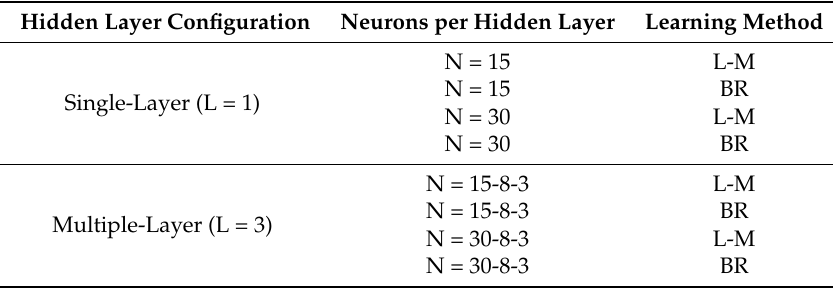
Table 2. Several tested ANN